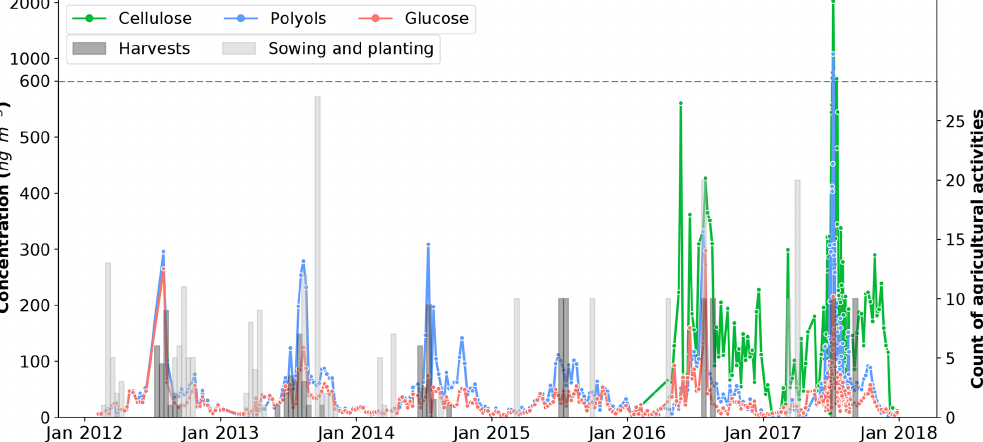
Figure 6. Daily evolution cycles of polyol and glucose concentrations in aerosols collected from the OPE-ANDRA monitoring site, from 2012 to 2018. Cellulose concentrations were measured from January 2016 to January 2018. Colored bars correspond to the sum of the various agricultural practices performed (data for 69 parcels are averaged over 12d for better clarity). Records of agricultural activities after October 2014 were available for only two parcels within the immediate vicinity of the PM 10 sampler. Records are multiplied by 10 for this period.